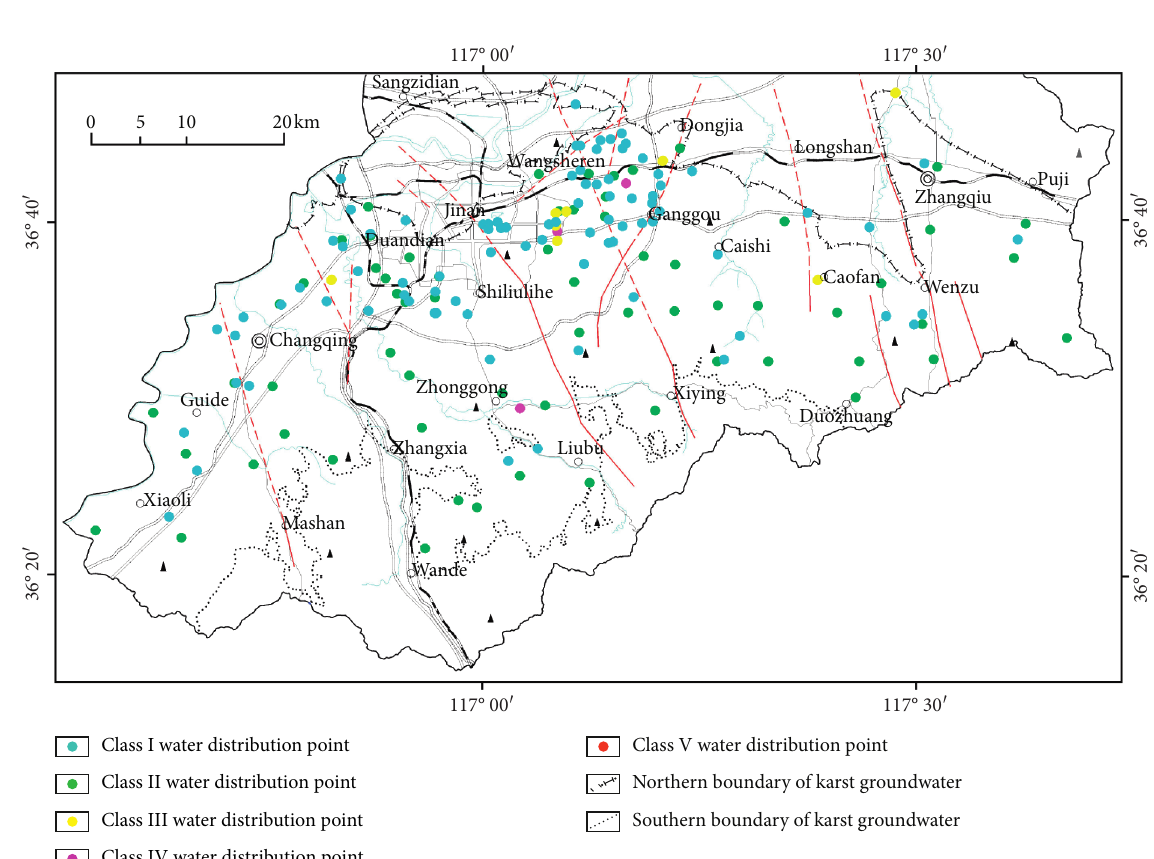
Figure 9: Comprehensive quality evaluation of toxic heavy metals in fractured karst